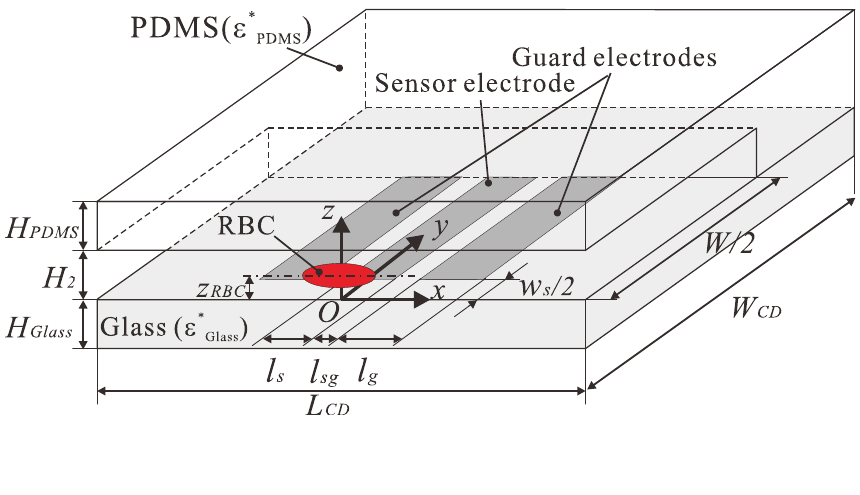
Figure 2. Computational domain of the numerical